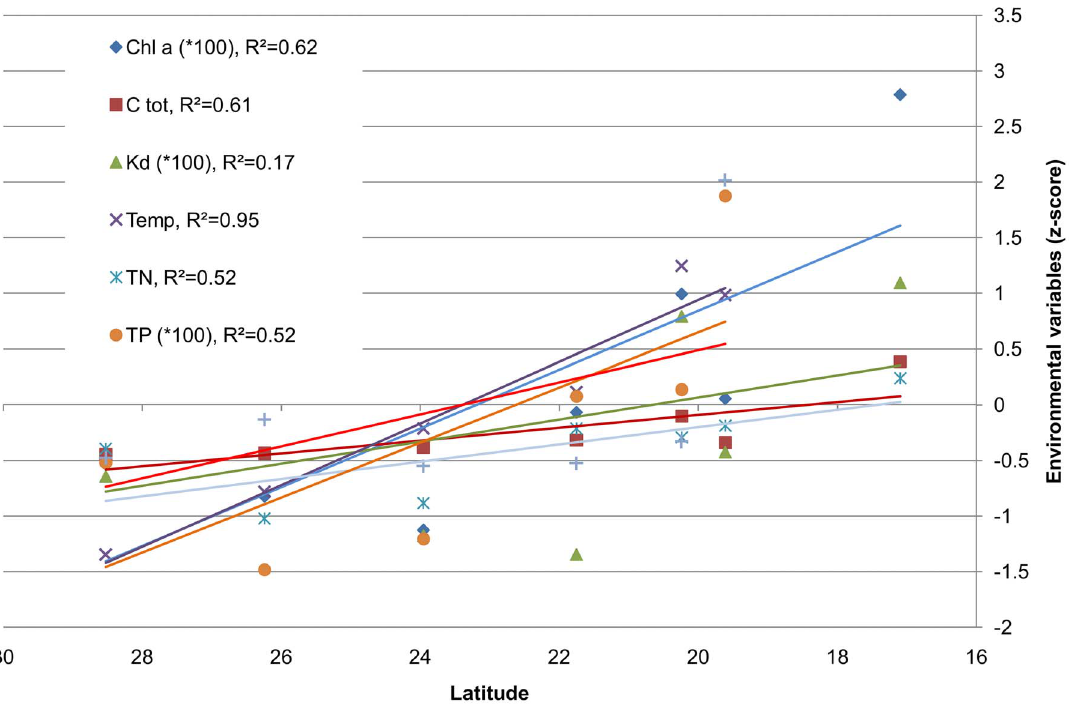
Fig. 2. Latitudinal shifts in selected environmental variables along the Saudi Red Sea coast from north to south (non-polluted sites only). Chl a 5 chlorophyll a concentration, Ctot 5 total carbon, Kd 5 coefficient of light extinction, Temp 5 temperature, TN 5 total nitrogen, TP 5 total phosphorus, The variables are presented as deviations from their respective all-sites-mean (z-scores). R 2 values indicate the variance explained by the respective linear model.